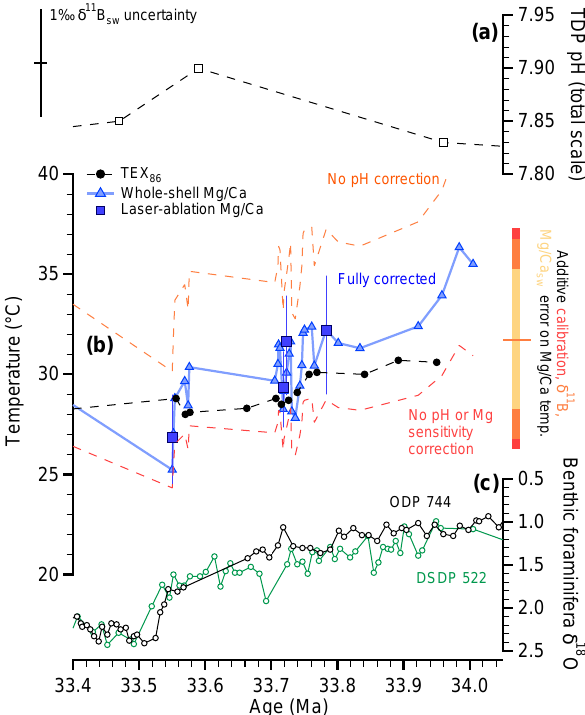
Figure 8. Panel (a) : EOT pH reconstruction from Pearson et al. (2009) based on Tanzania Drilling Project samples. The error bar is derived from an uncertainty in δ 11 B sw of ± 1‰. Panel (b) : sub- tropical sea surface temperature from Mg / Ca and TEX 86 . These absolute Mg / Ca temperatures are the first to be adjusted for both the pH effect on Mg incorporation and the nonlinear relation- ship between seawater-shell Mg / Ca and temperature. St. Stephens Quarry Mg / Ca data from both solution ICPMS (Wade et al., 2012) and laser ablation (this study) are shown. The combined Mg / Ca error estimate is that due to uncertainty in the Mg / Ca sw ratio ( ± 0 . 5molmol − 1 ), δ 11 B sw , and in the calibration regressions of Evans et al. (2016). The corrected Mg / Ca data imply ∼ 6 ◦ C of precursor cooling at ∼ 33.9Ma. Panel (c) : ODP Site 744 and DSDP Site 522 benthic foraminifera δ 18 O (Zachos et al., 1996). Note that the inter-interval Mg / Ca and δ 11 B sw error (i.e. the error in relative changes) is far smaller than shown by the